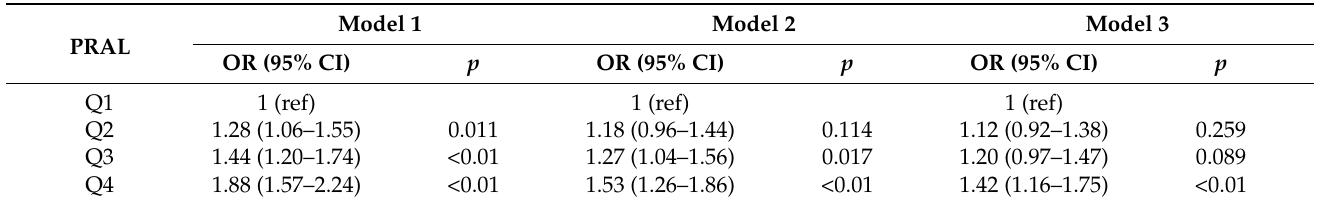
Table 3. Odds ratios (ORs) and 95% confidence intervals (CIs) for hyperuricemia risk based on PRAL.